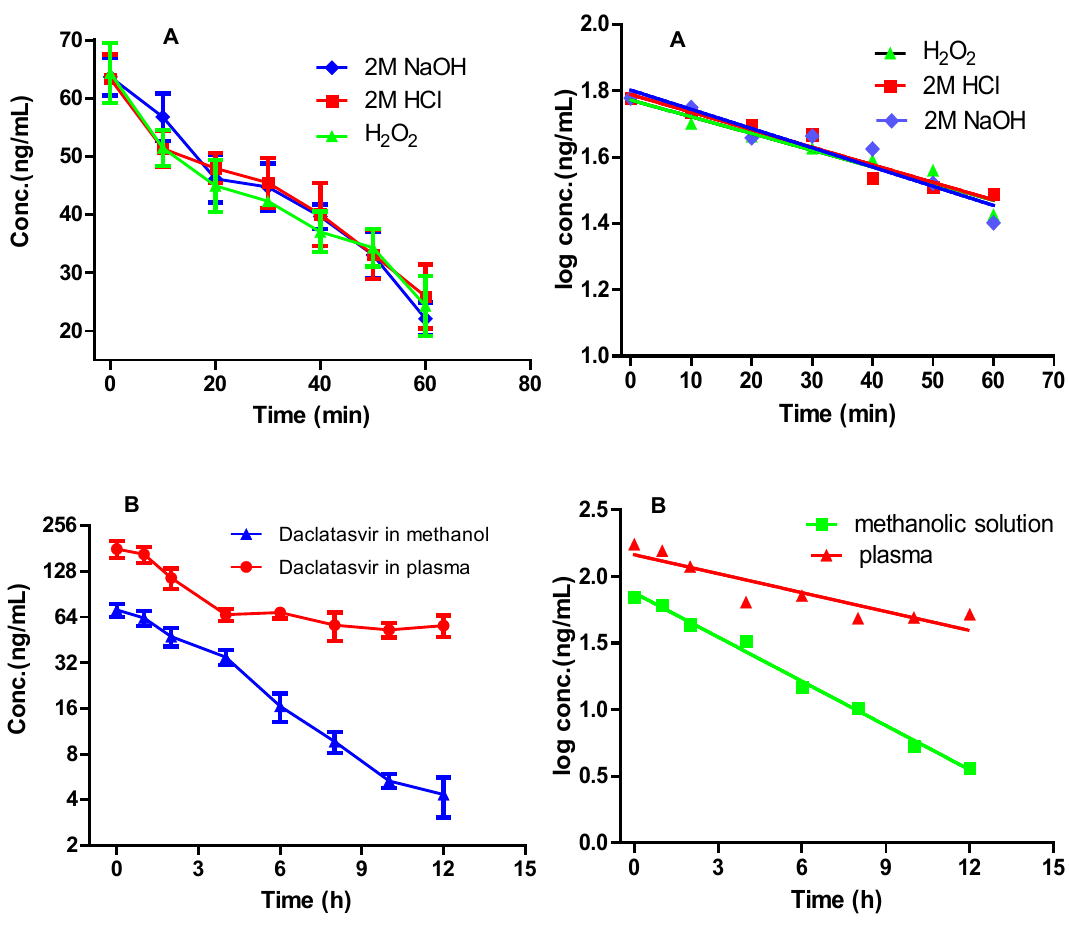
O (A), and direct sunlight (B) on DCV 2 2